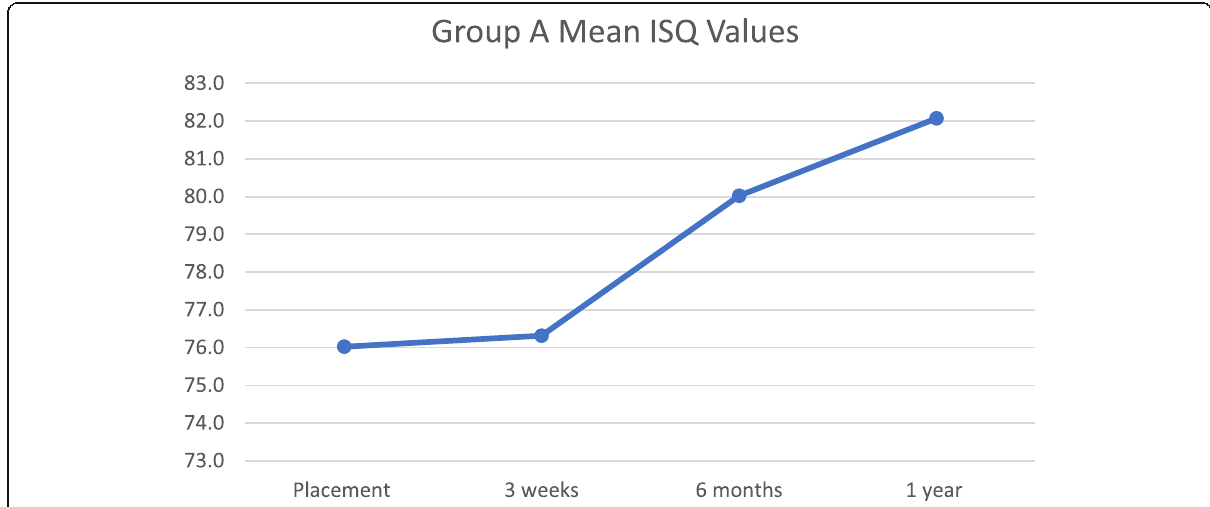
Fig. 1 Group A mean ISQ values. This graph depicts change in mean ISQ values for Group A at placement, 3 weeks, 6 months, and 1 year